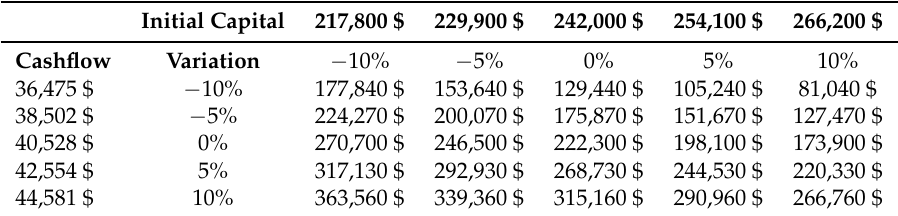
Table 4. RETScreen software sensitivity analysis.